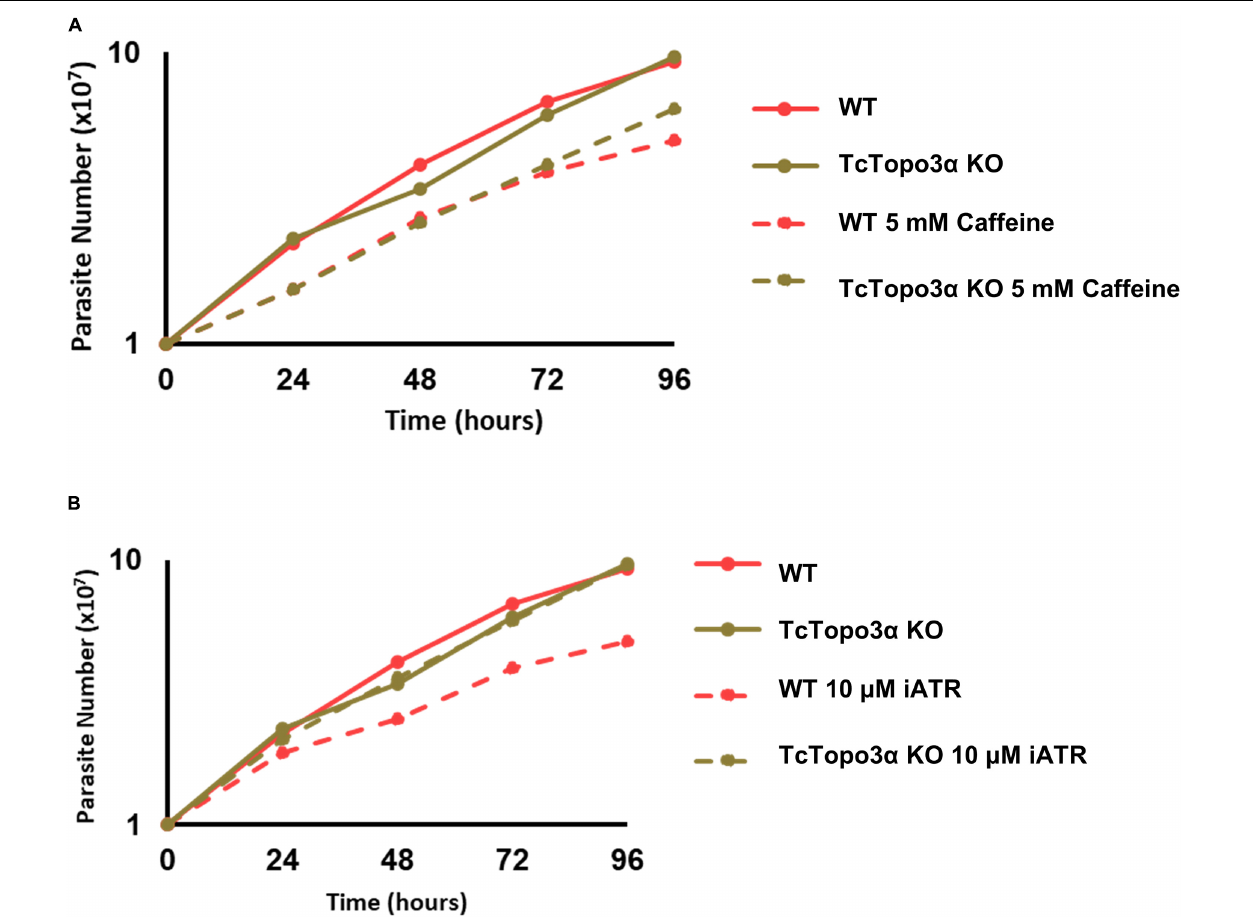
FIGURE 9 | The effect of ataxia telangiectasia mutated (ATM)/ataxia telangiectasia and Rad3-related (ATR) inhibition in TcTopo3 α KO parasites. (A) Growth curve after the treatment with 5 mM caffeine. The caffeine was kept in the LIT medium during all experiment time analysis (144 h). (B) Growth curve after the treatment with 10 µ M of ATR inhibitor (VE-821). The ATR inhibitor was kept in the LIT medium during all experiment time analysis (144 h). The cells were counted every day using a cytometry chamber and vital dye erythrosine. Representative results of three distinct experiments are